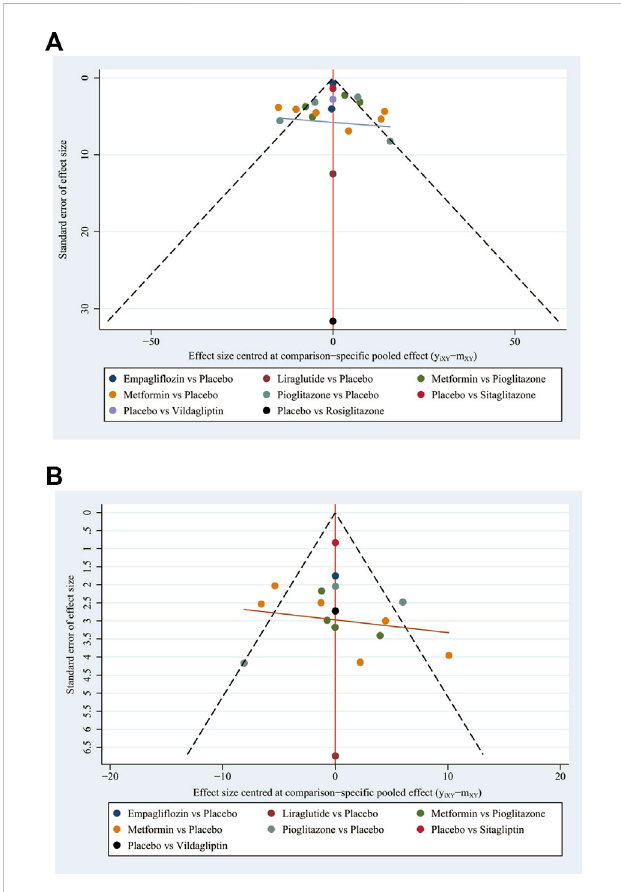
FIGURE 4 Funnel plot on publication bias (A) ALT. An asymmetrical graph suggested that there might bepublishing bias whilea symmetrical graph showednoclearpublicationbias.Funnelplotonpublicationbias (B) AST. An asymmetrical graph suggested that there might be publishing bias while a symmetrical graph showed no clear publication